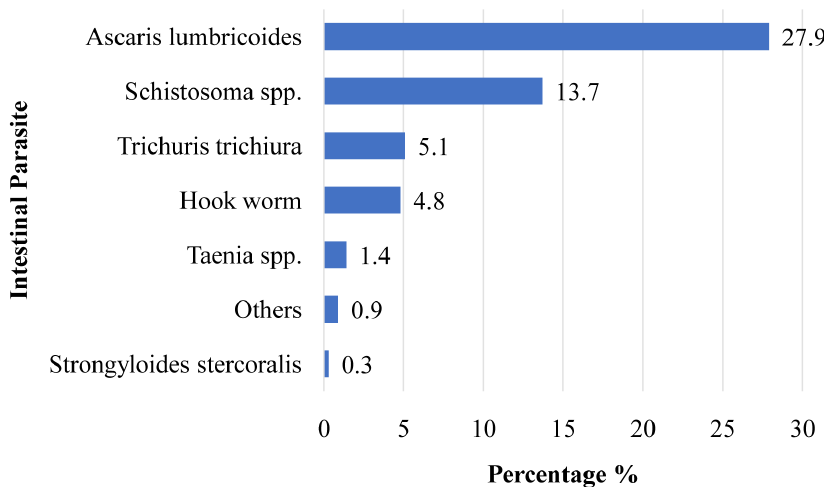
Figure 1. Prevalence of parasitic infections among ANC attendants at health centers in Hawassa, Southern Ethiopia, 2020.